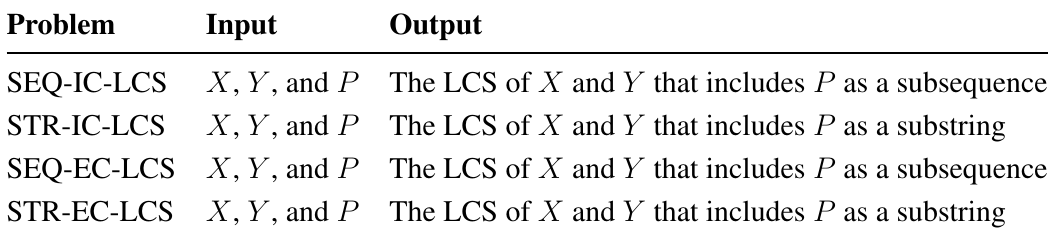
Table 1. The generalized-constrained-longest common subsequence (GC-LCS) problems. STR-EC,